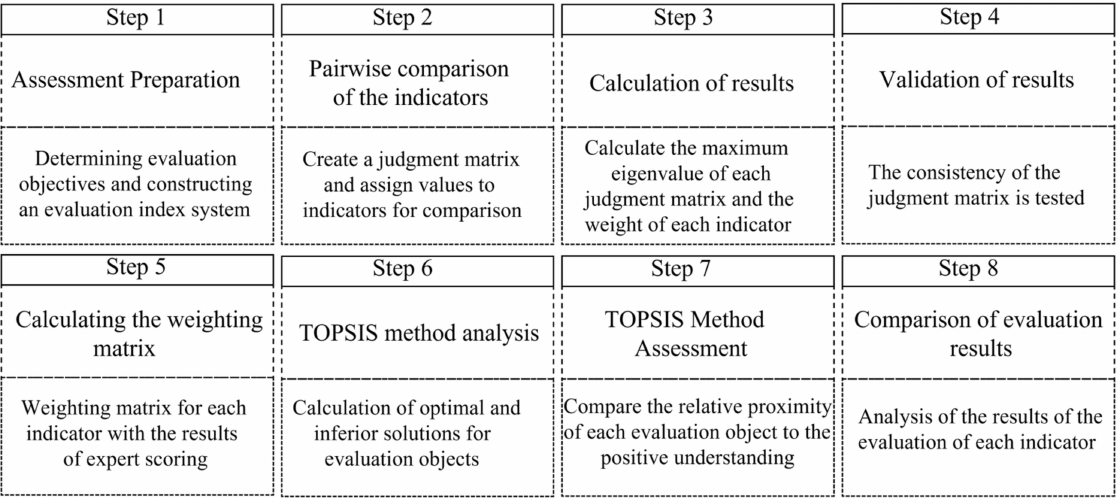
Figure 1. Flow chart of the evaluation